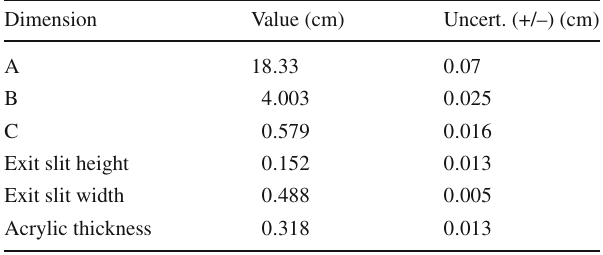
Fig. 10 A rending of the experimental setup as modeled in RAT. Sev- eral key elements and dimensions are labeled. Values and uncertainties for the dimensions are given in Table 2. Dimension A is the distance fromthecenterofthediffractiongratingfacetothemonochromatorexit slit. Dimension B is the distance from the exit slit to the TPB surface. Dimension C is the distance from the TPB surface to the photodiode surface Table 2 Important apparatus dimensions and their